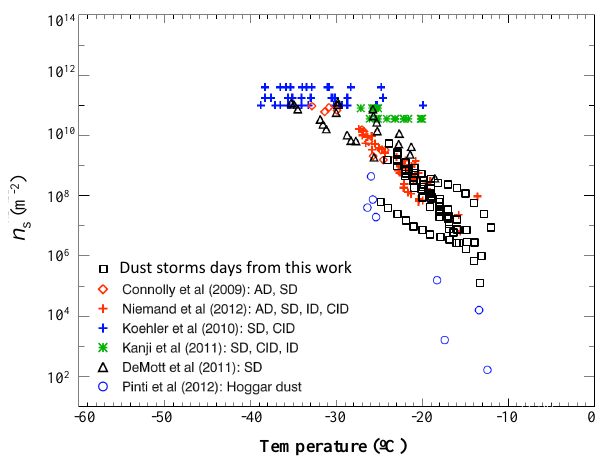
Figure 9. INAS densities as a function of temperature from Hoose and Möhler (2012), with dust storm days from this work in black squares. It is worth noting the similarity between the present results from immersion freezing and those obtained by means of a different nucleation mode and using different types of desert dusts such as Asian dust (AD), Canary Island dust (CID), Saharan dust (SD) and Israeli dust (ID).